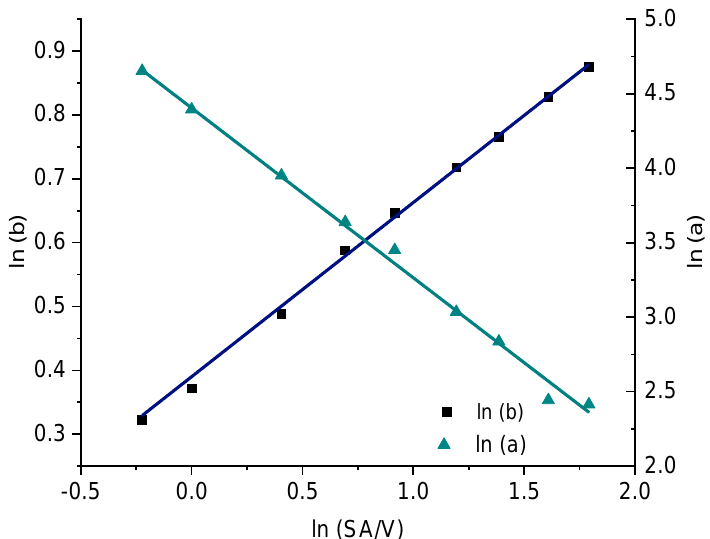
Figure 11. Correlation of the constants a and b of the Weibull function with the SA/V ratio for the PVA-PZQ formulation.